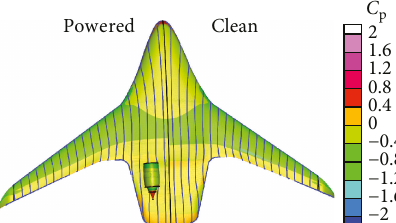
Figure 12: Upper surface pressure contour and streamlines of the clean and powered con fi gurations at the cruise